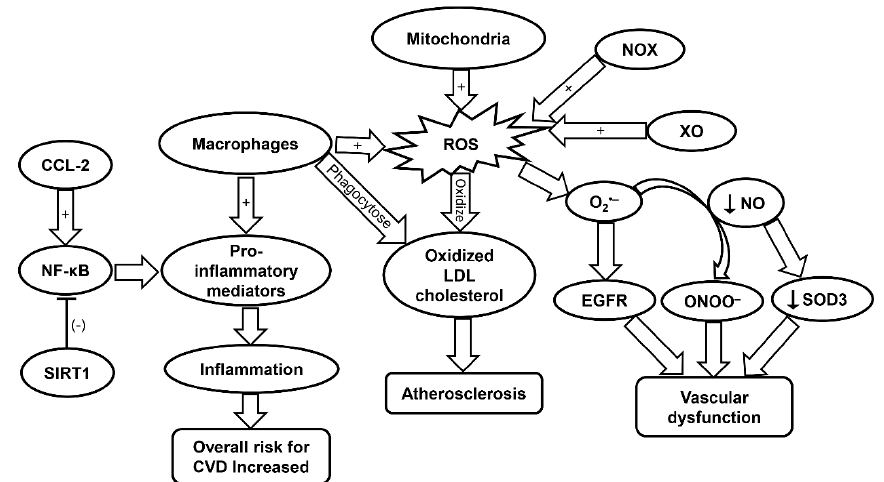
Figure 1. Schematic summarizing the molecular mechanisms contributing to CVD progression. CCL- 2, chemokine (C-C motif) ligand 2; CVD, cardiovascular disease; EGFR, epidermal growth factor receptor; LDL, low density lipoprotein; NF- κ B, nuclear factor kappa-light-chain-enhancer of activated B; NOX, NADPH oxidase; ROS, reactive oxygen species; SIRT1, sirtuin-1; SOD, superoxide dismutase; XO, xanthine oxidase.